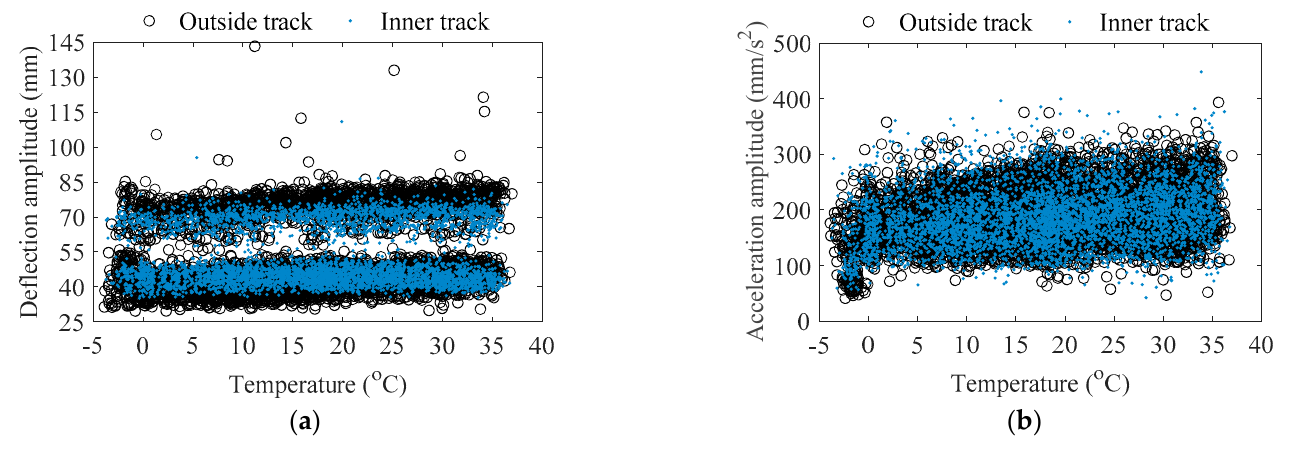
Figure 6. Amplitude of train-induced non-stationary response versus temperature at Section G: ( a ) deflection; ( b ) acceleration.